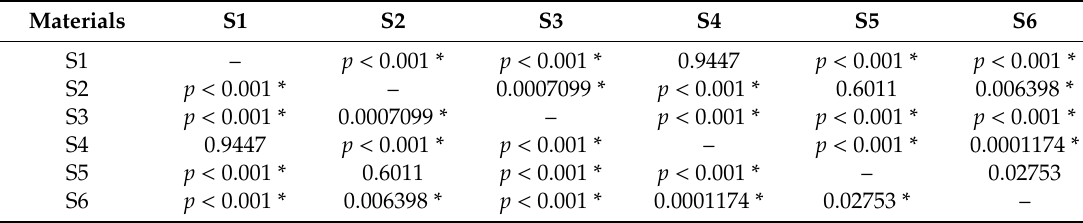
Table 2. Di ff erences in ∆ E after 168 h immersion in tea.